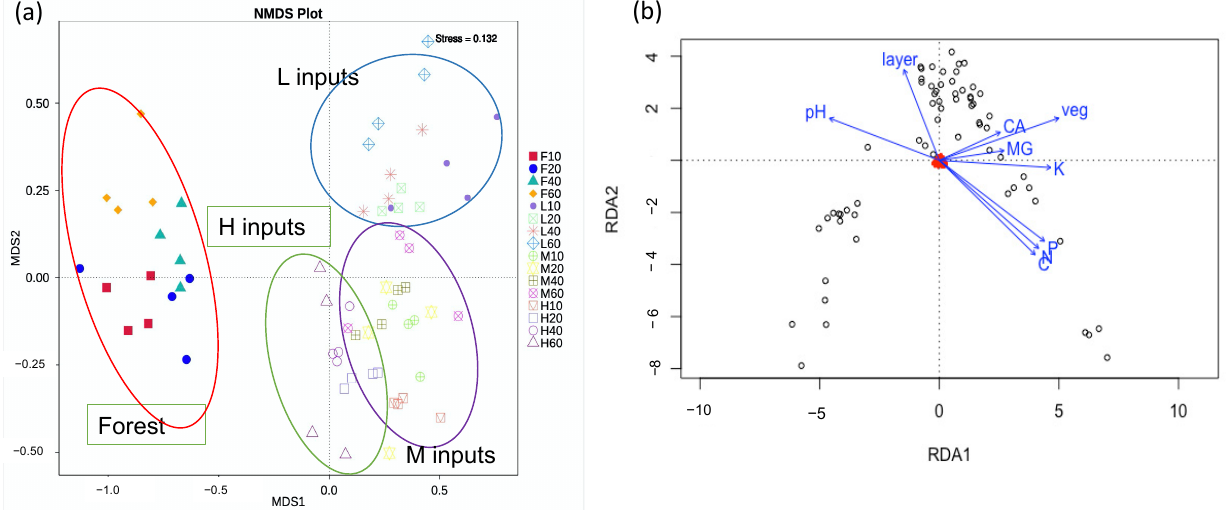
Figure 3. ( a ) NMDS plot showed that fungal communities varied between forest and tea plantations. ( b ) RDA analysis the correlation between fungal diversity indexes with environmental factors. Layer: soil layers, H: fungal Shannon diversity, S: species richness, apha: apha diversity, veg: vege- tation types, CA: soil total Ca, MG: soil total Mg, P, N, C: soil total P, N, C. Table 1. Indicator analysis figured out the factors combine to explain the variations of fungal com- munities. *** means p < 0.001(Duncan Multiple Range Test).